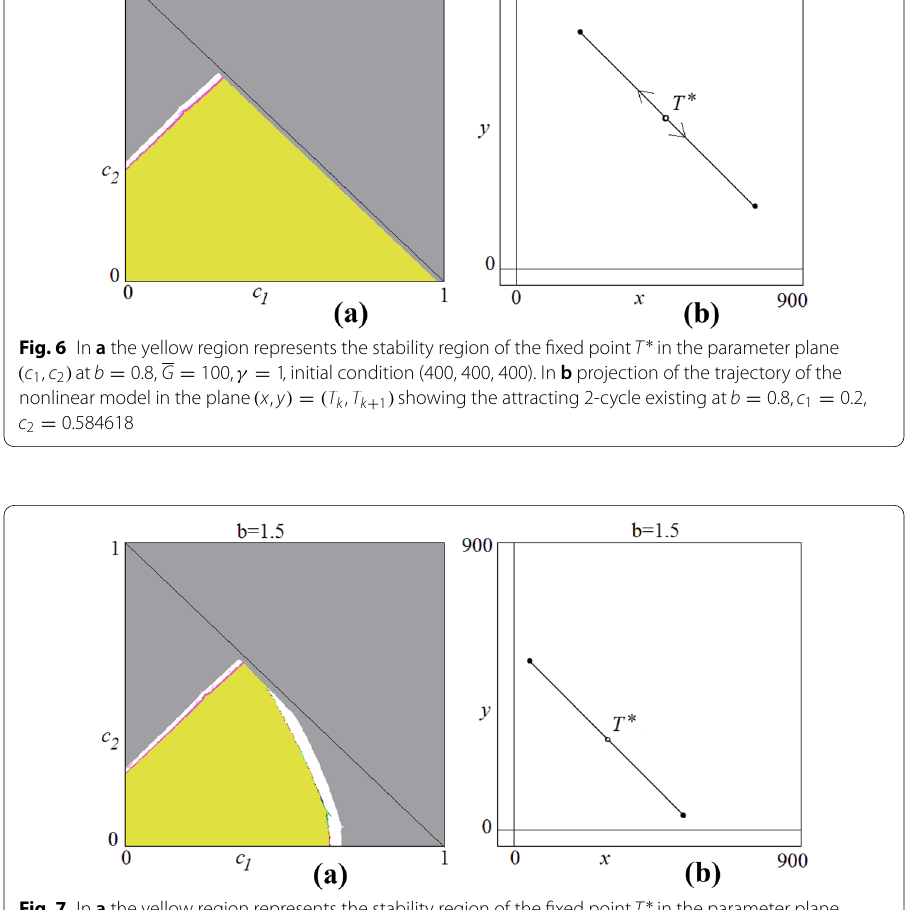
Fig. 7 In a the yellow region represents the stability region of the fixed point T ∗ in the parameter plane 1.5 , G 100, γ 1, initial condition (400, 400, 400). In b projection of the trajectory of the ( c 1 , c 2 ) at b = = = ( T k , T k nonlinear model in the plane ( x , y ) 1 ) showing the attracting 2-cycle existing at b = 1.5, c 1 = 0.2, = + c 2 =